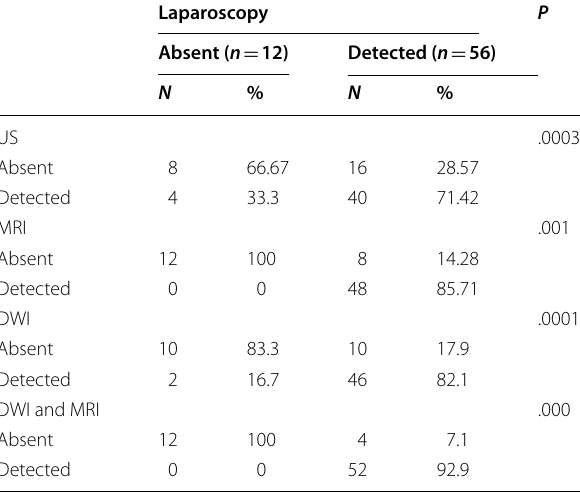
Table 4 Comparison of US, MRI, DWI, combined MRI and DWI results according to laparoscopy